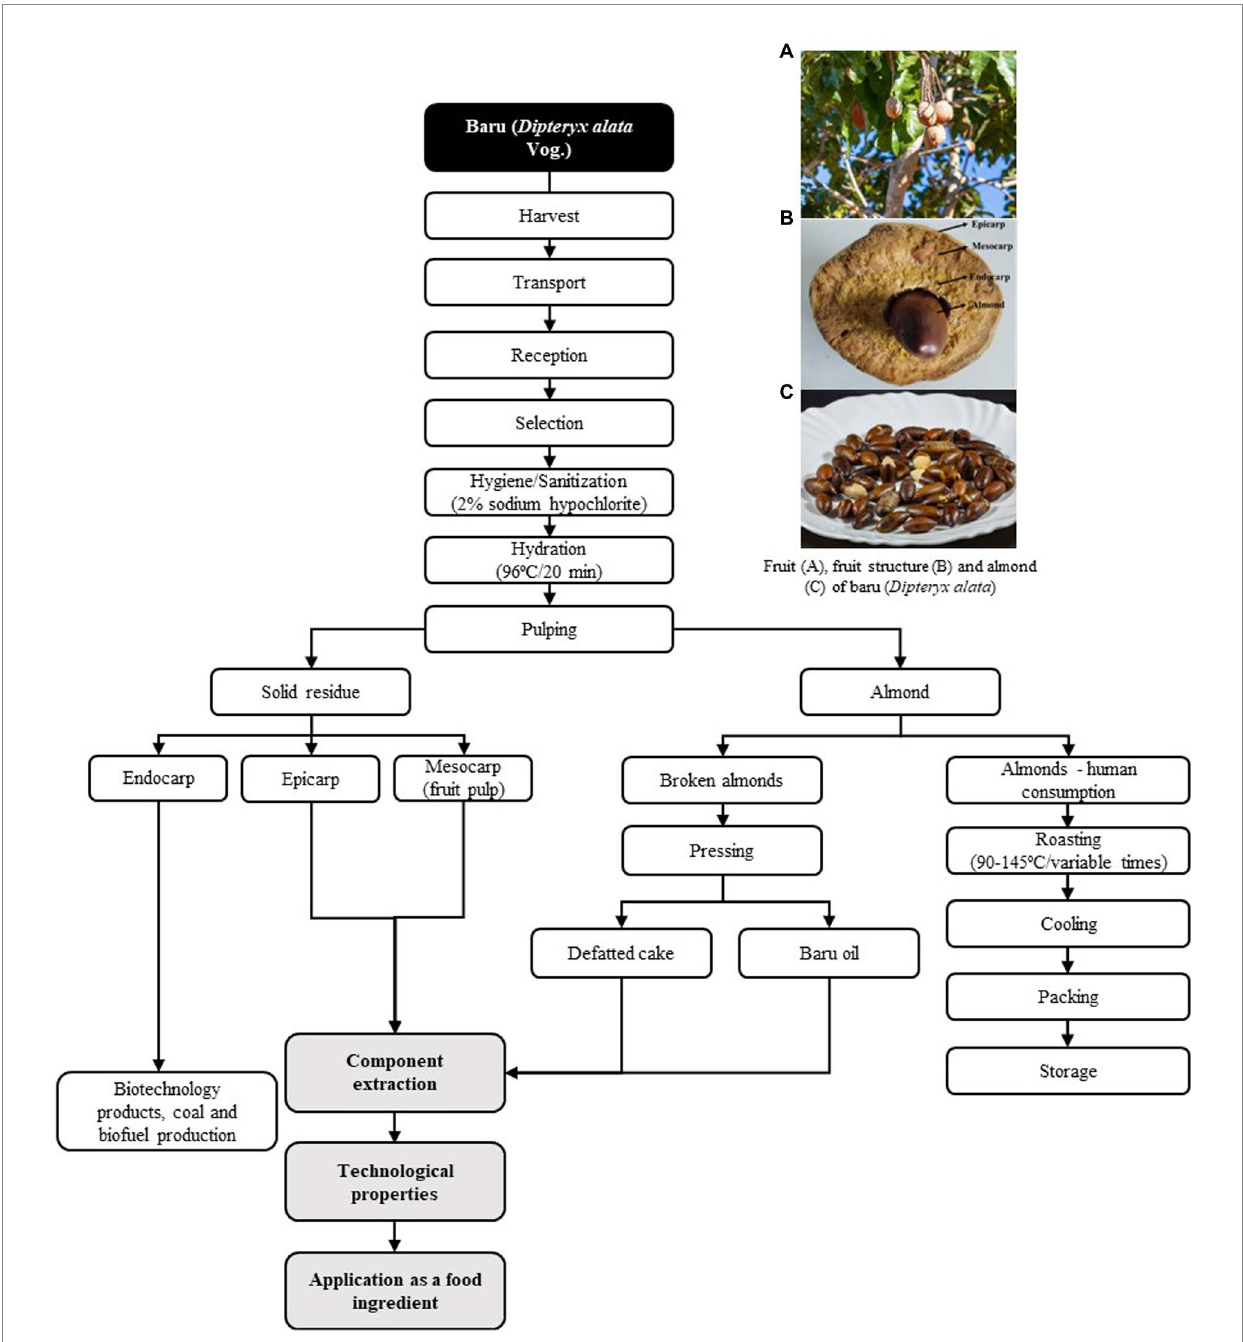
FIGURE 1 Baru almond production flowchart, generation of by-products and technological applications in plant-based food. A - baru fruit still on the trees, B - baru fruit and its parts being epicarp, mesocarp, endocarp and almond; and C - baru